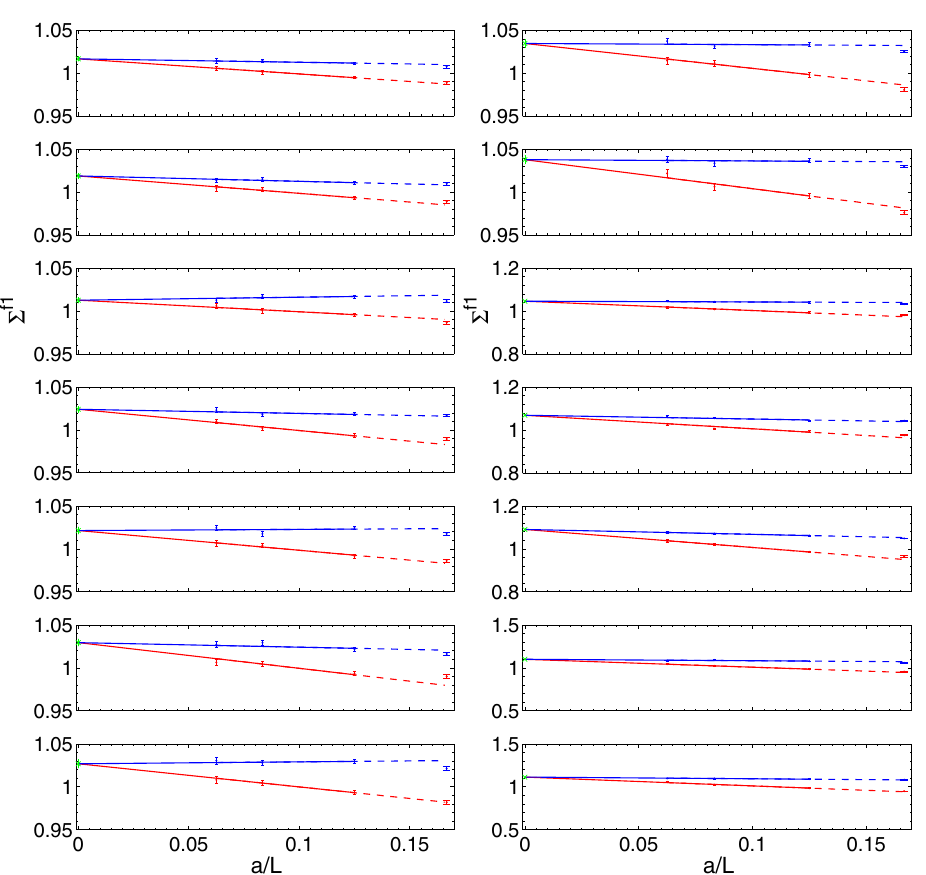
Fig. 3 Continuum limit extrapolations of the N f = 0 SSF for the renormalization scheme α = 0. Blue (red) points correspond to results with the O ( a ) improved (unimproved) action,